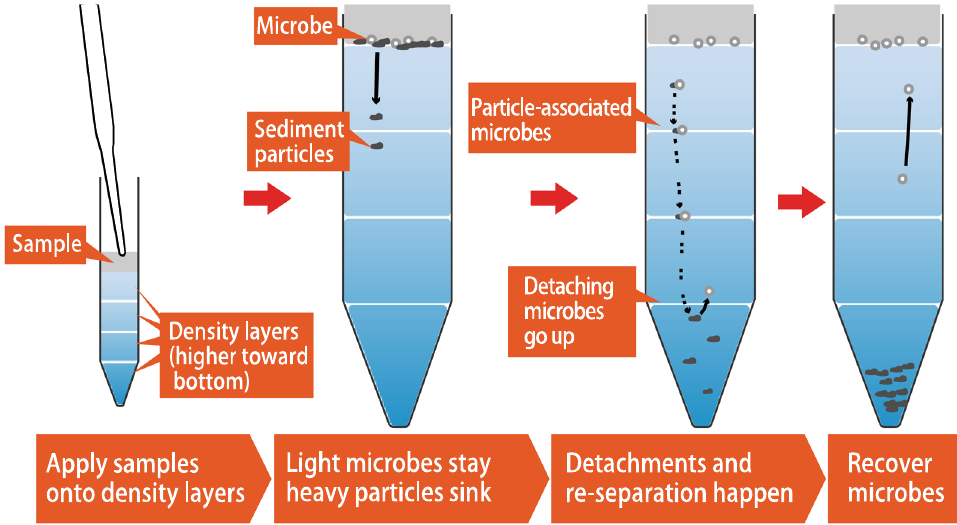
Fig. 4 Scheme of cell separation by multiple density layers. By using multiple density layers, better recovery of microbes was achieved than bilayer